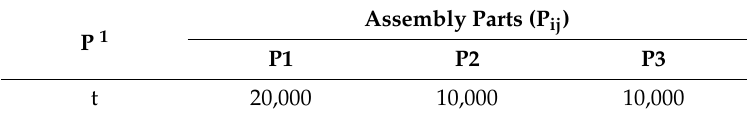
Table 6. Demand for assembly parts.